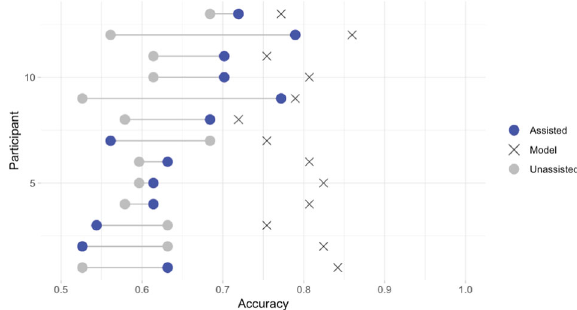
Fig. 2 Diagnostic accuracy of the assisted physicians, stand-alone algorithm, and unassisted physicians. Each cross represents the stand-alone algorithm ’ s performance on test data that was assigned as assisted cases for the correspondent physician. Algorithm performance under different training strategies Evaluated on the full test set, the algorithm achieved an accuracy